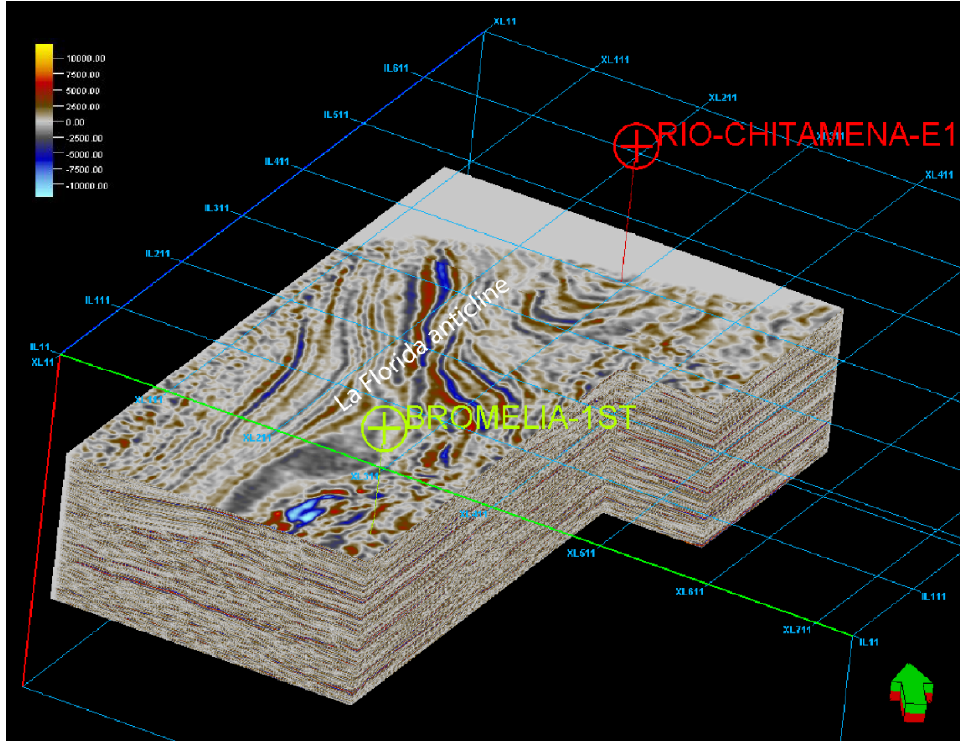
Figure 6. 3D Seismic amplitude volume of the La Florida anticline showing the well locations.